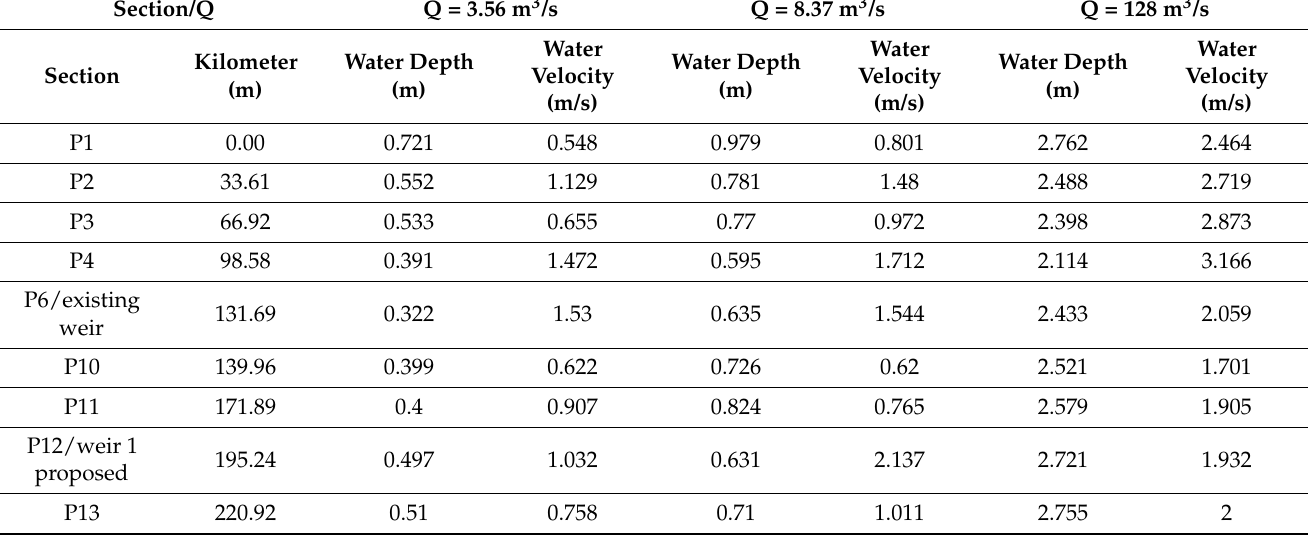
Table 3. The depth and velocity of the water in each cross-section for all simulated flows. For the proposed case with the lowering of the crest of the existing weir and the construction of three new weirs of low height downstream of it.